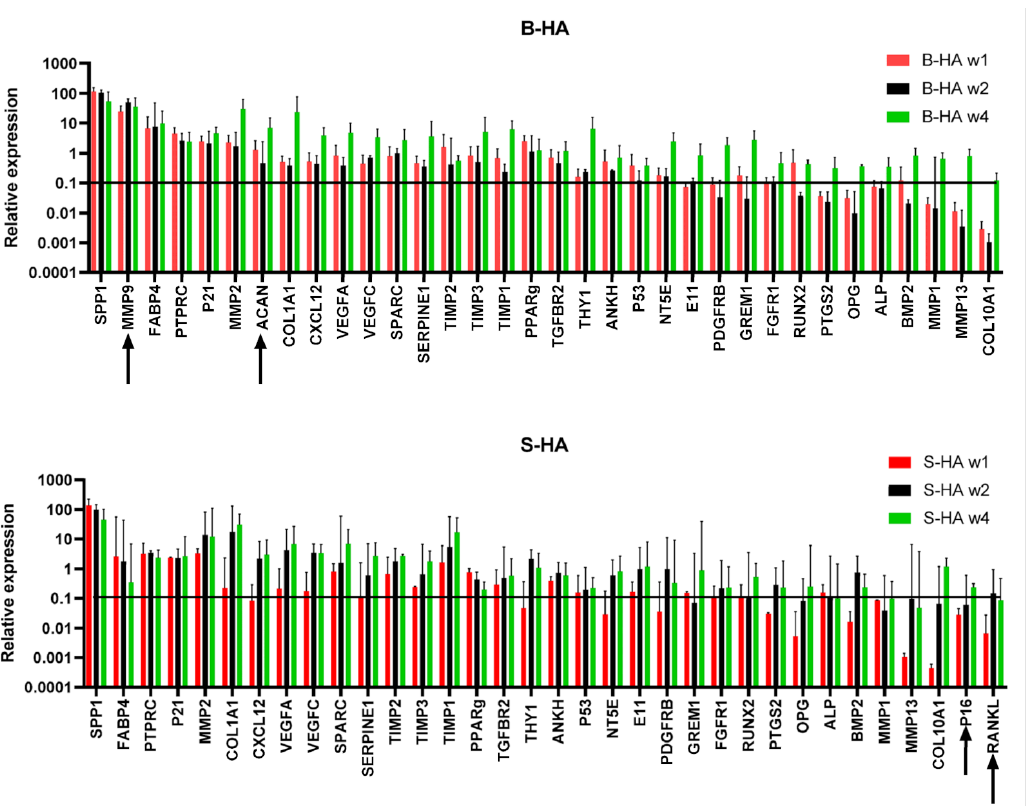
Figure 6. Gene expression of BMSCs normalised to HPRT. Top panel shows the gene expression of transcripts on B-HA, and the bottom panel shows gene expression of transcripts on S-HA for week 1, 2 and 4. Data were normalised to the housekeeping gene HPRT1 , indicated with the black horizontal line. Black arrows indicate genes that displayed expression levels lower than that of the housekeeping gene. Data are shown as mean with standard error of mean for n = 6